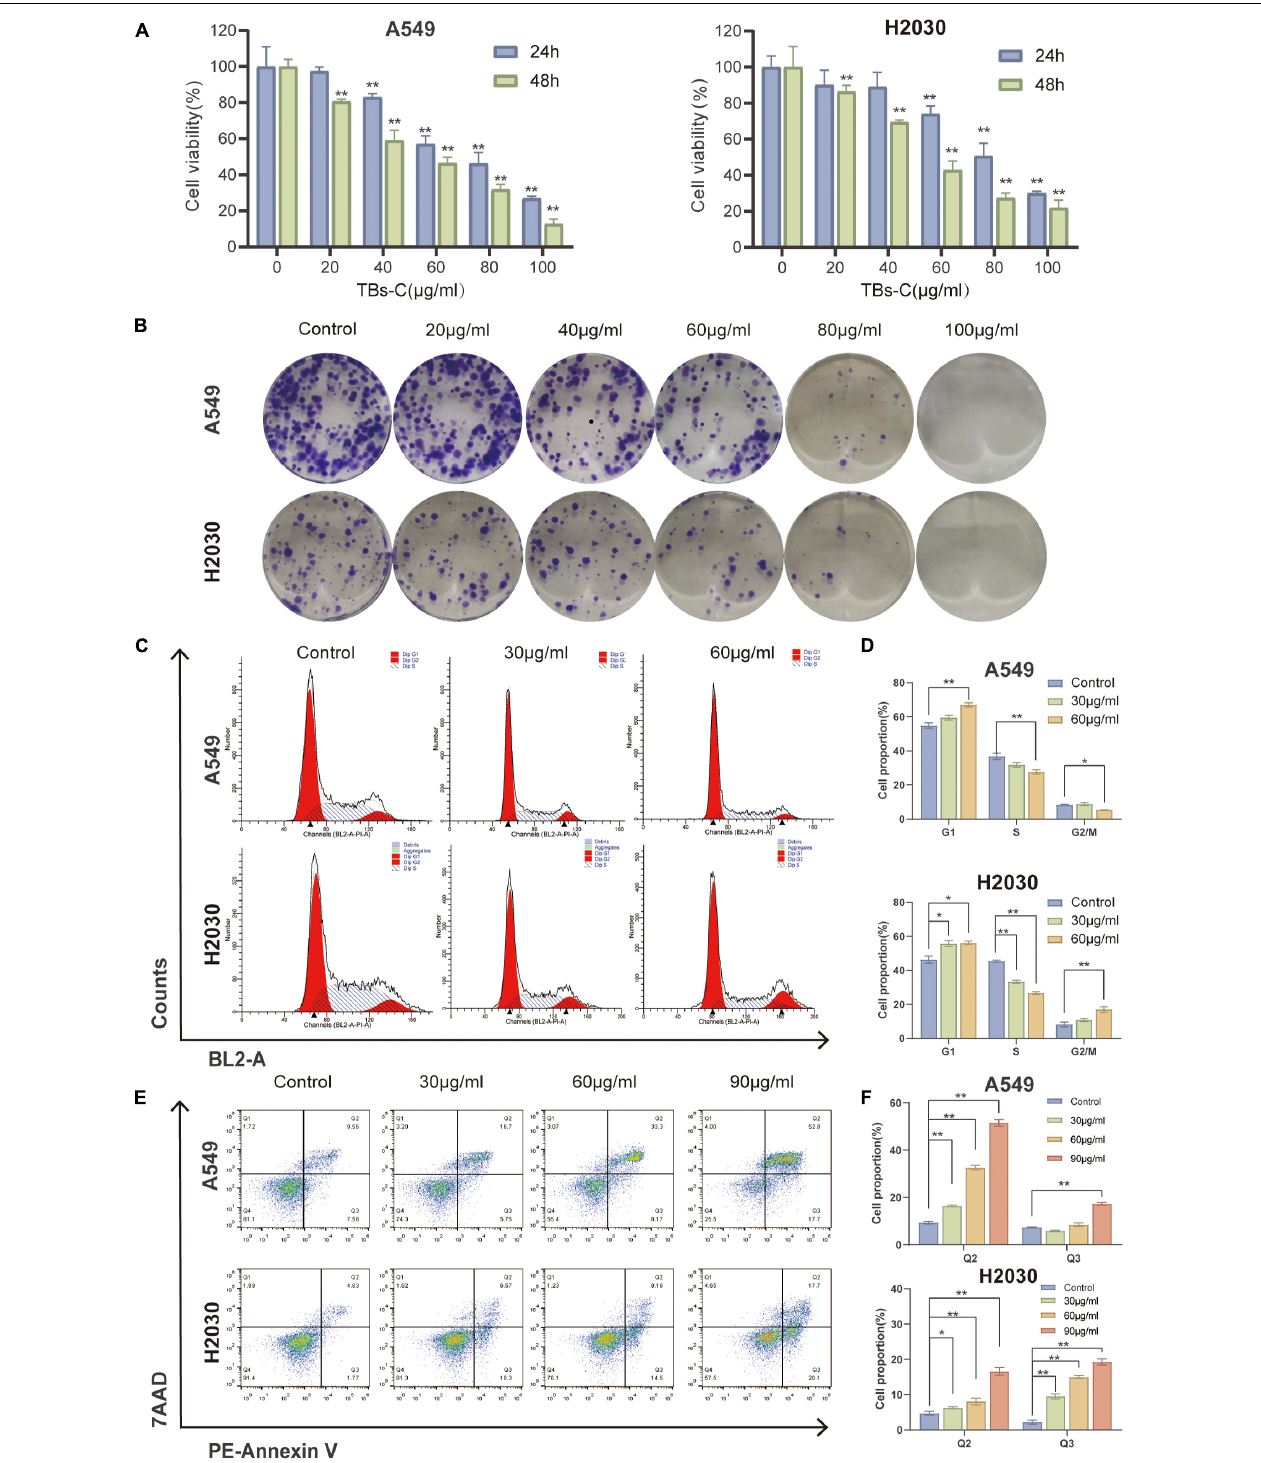
FIGURE 2 | Effects of TBs-C on lung cancer cell proliferation, apoptosis, and cell cycle in vitro . (A) The CCK-8 assay was performed to determine the viability of A549 and H2030 cell lines after 24 and 48 h of treatment with different doses of TBs-C. (B) The capacity of A549 and H2030 cell lines to form clones was examined at varying concentrations of TBs-C. (C) The analysis of the cell cycle by flow cytometry after a 24 h treatment with TBs-C is depicted. (D) Quantitative results of the cell cycle analysis. (E) Evaluation of the apoptosis of cells treated for 24 h of TBs-C by AnnexinV-7AAD flow cytometry. (F) Quantitative analysis of cell apoptosis, * p < 0.05, ** p <